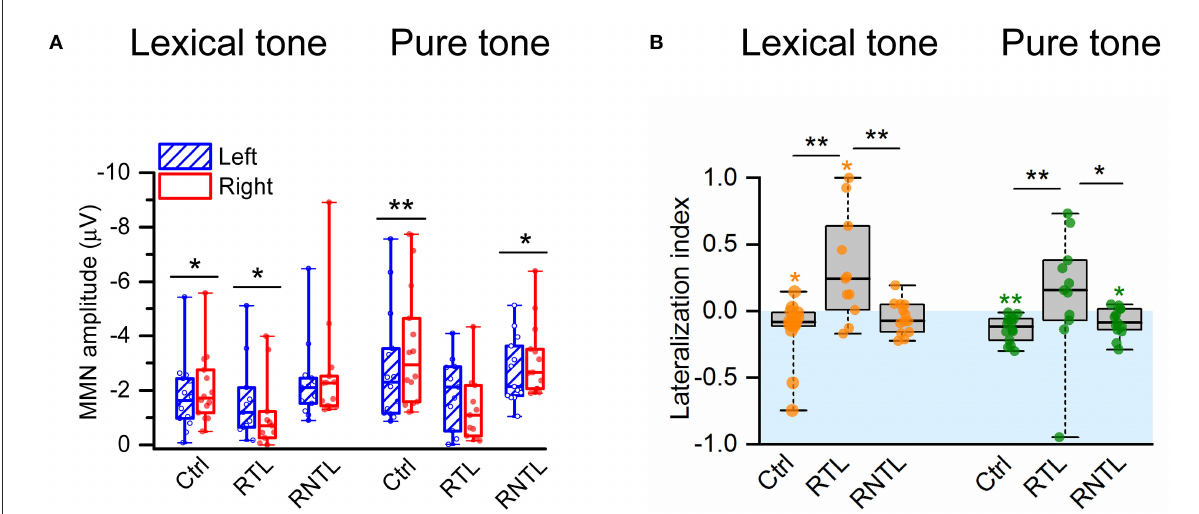
FIGURE3 MMN amplitudes and lateralization index (LI) were recorded from four electrodes on the left (F3, FC1, FC5, C3) and four electrodes on the right (F4, FC2, FC6, C4) sides of the scalp. (A) MMN was significantly larger in amplitude on the right side of the scalp than on the left in the control group for the lexical-tone contrast and the pure-tone contrast and in the RNTL group for the pure-tone contrast but larger in amplitude on the left side of the scalp than on the right in the RTL group for the lexical-tone contrast. (B) The comparisons for LI within each group and among groups. The analysis within the group indicates that the LI was significantly less than zero (indicates right hemisphere lateralized response) in the control group for the lexical-tone contrast and the pure-tone contrast and in the RNTL group for the pure-tone contrast but greater than zero (indicates left hemisphere lateralized response) in the RTL group for the lexical-tone contrast. The analysis among groups indicates that the LI in the RTL group was larger than that in the control group and the RNTL group for each stimulus condition. Box plots depict medians with interquartile ranges and whiskers represent the minimum and maximum values. * P < 0.05, ** P < 0.01.